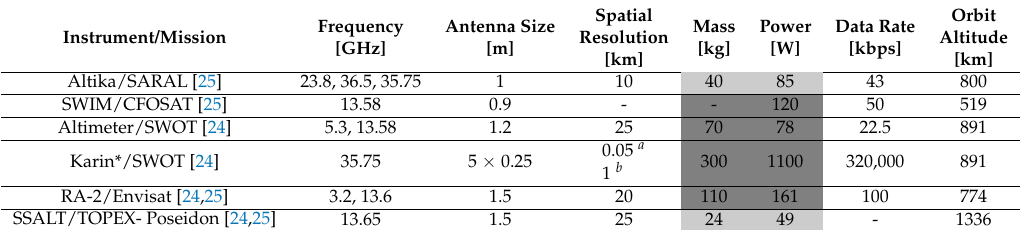
Table A10. Survey of Radar Altimeter instruments.